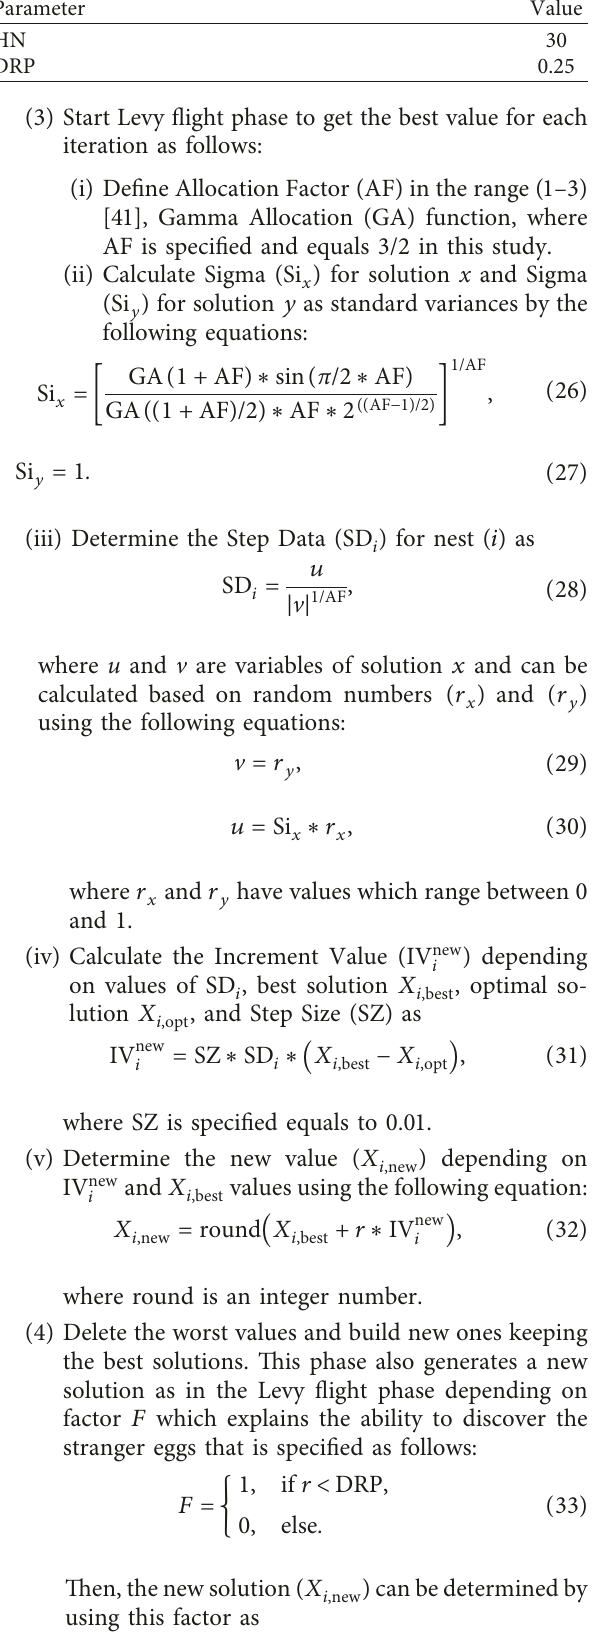
Table 4: Initializing parameters of the CS algorithm.